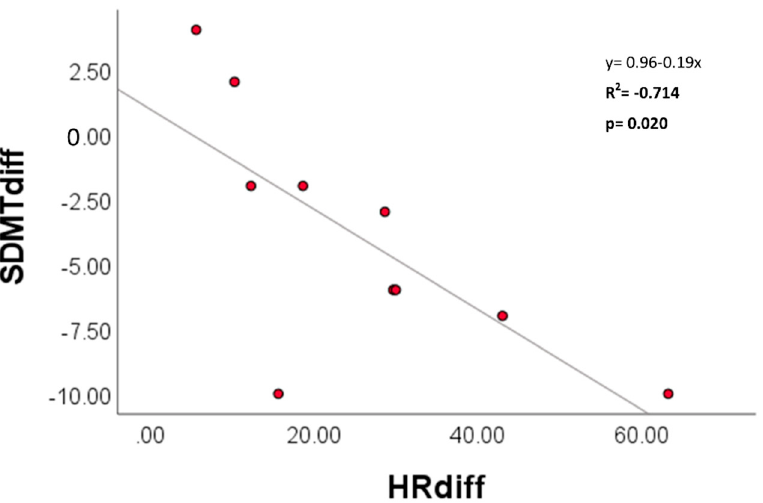
Figure 5. Significant correlations in change score between trials at Step I for SDMT and heart rate (HR).